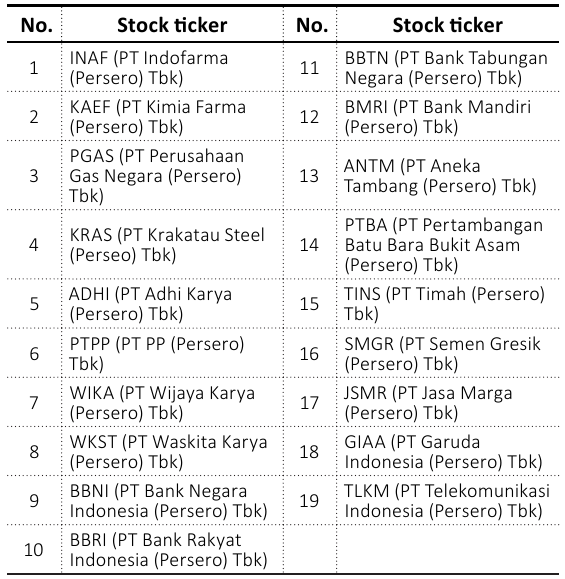
Source: Secondary data,